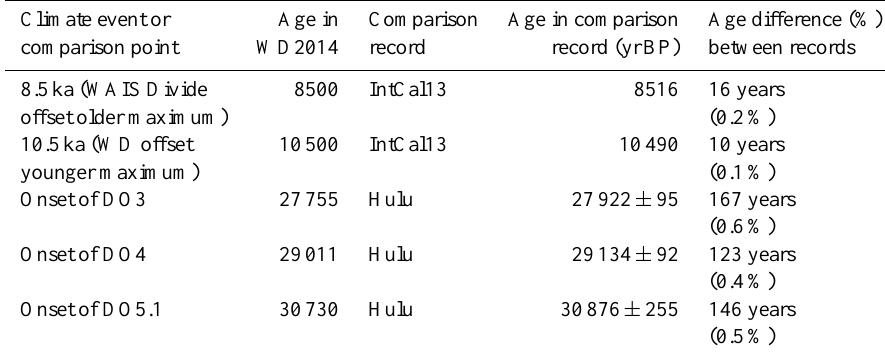
Table 3. Comparison of the WD2014 ice core chronology to independent chronologies, Hulu Cave (Wang et al., 2001; Buizert et al., 2015; Edwards et al., 2016) and tree-ring-based IntCal13 radiocarbon curve (Reimer et al., 2013). A detailed description and discussion for the WAIS Divide (cid:49) age estimation and synchronization procedures between the WAIS Divide CH 4 record Hulu δ 18 O Calcite record is provided by Buizert et al. (2015).